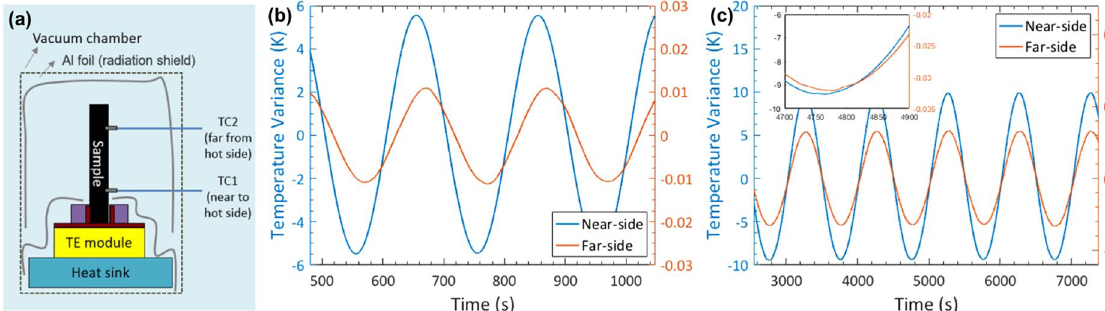
Figure 5. Angstrom method: ( a ) Schematic of the setup. Measured temperature wave of ( b ) p-type BST and ( c ) n-type BTS in the Angstrom setup. P-type BiSbTe